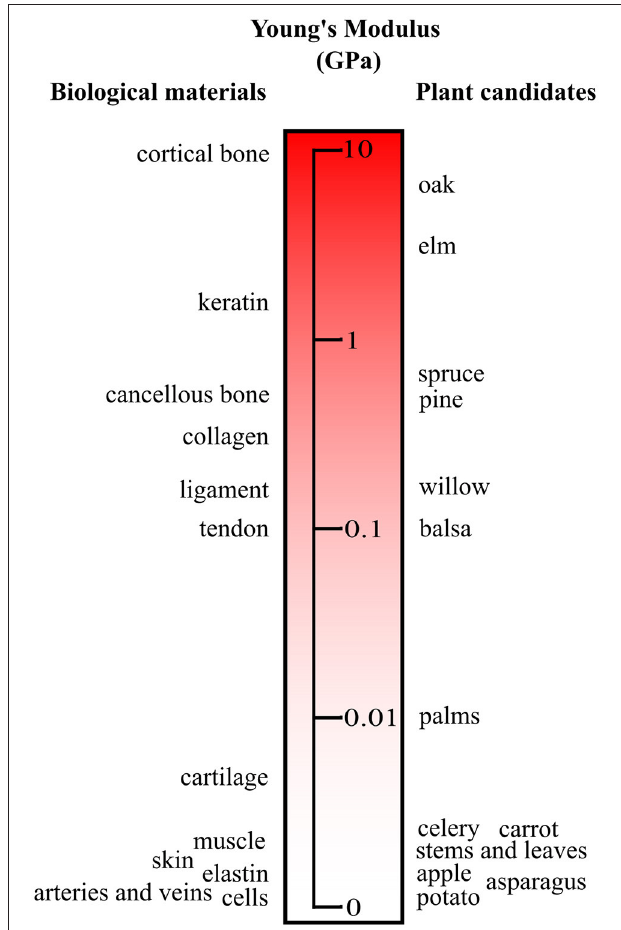
FIGURE 4 | Young’s modulus of plant materials and human tissues. A small subset of plant candidates are compared to key biological tissue stiffnesses. The source material can be selected to match the elasticity of the native tissue. It should be noted that with processing and modifications the moduli of the plant candidates can be tuned. Adapted from Gibson et al. (2010) with permission from Cambridge University